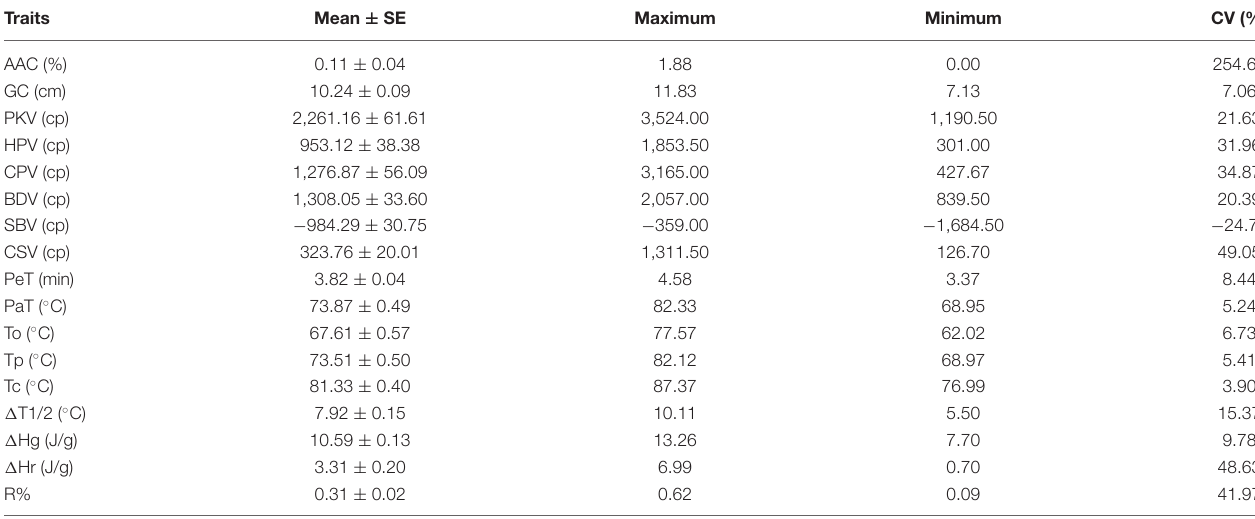
TABLE 1 | The phenotypic data of different glutinous rice germplasms. Traits